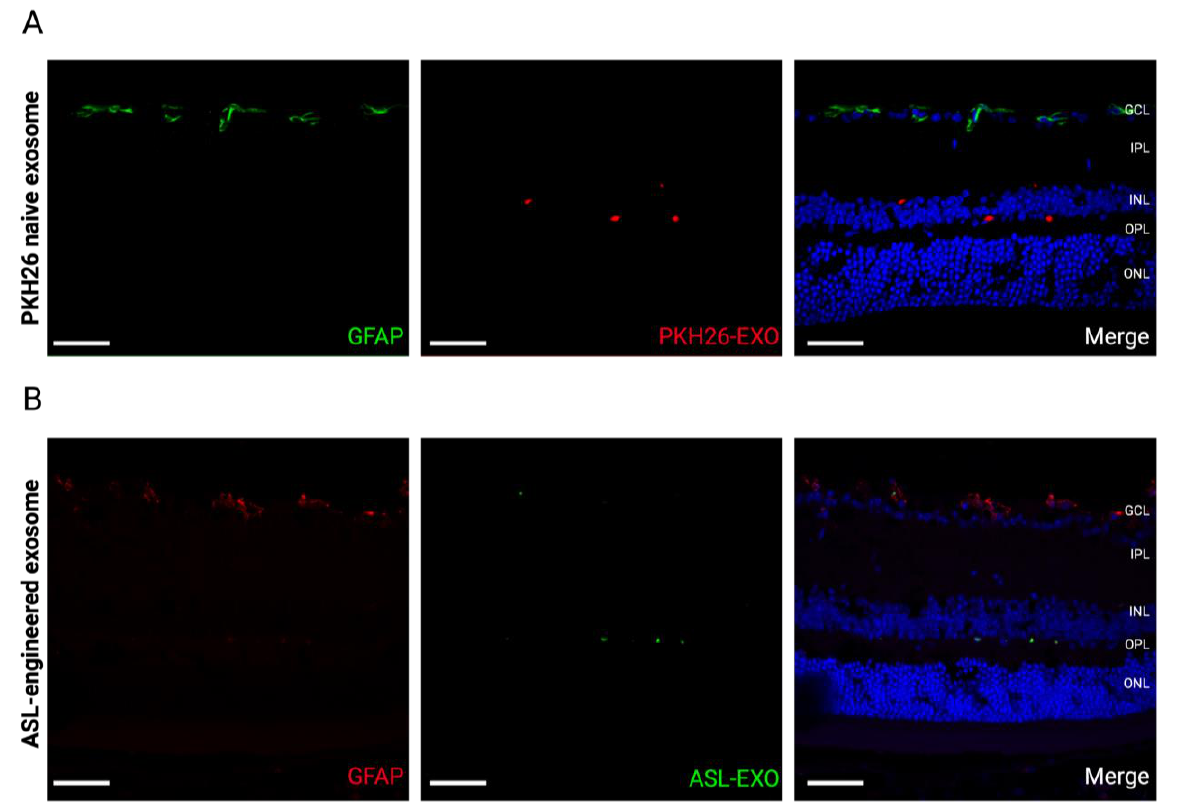
Figure 7. No immediate reactive retinal gliosis by intraocular exosome treatment. Retinal sections show no immediate reactive retinal gliosis stained with GFAP antibody staining 1 day after intravitreal injection of PKH-26-labeled exosomes ( A ) and 7 days after the intravitreal injection of ASL exosomes ( B ) (Scale bar, 50 μm ). Note that GFAP is only expressed within ganglion cells in a physiologic state.